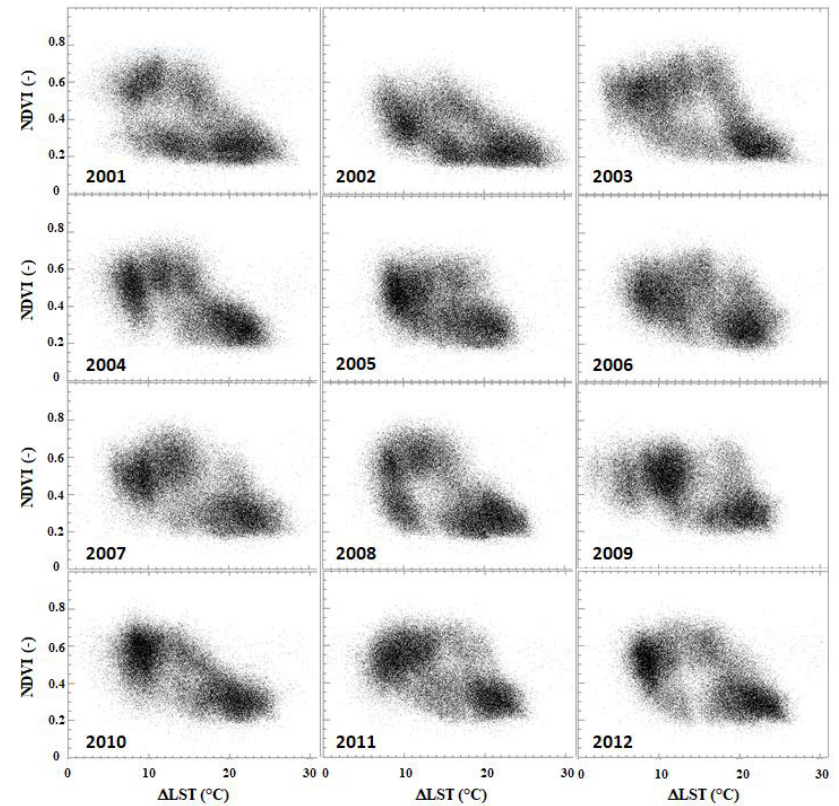
∆ LST scatter-plots sequence for the whole investigated Figure 6. NDVI vs. Δ LST scatter-plots sequence for the whole investigated period. Figure 6. NDVI vs.